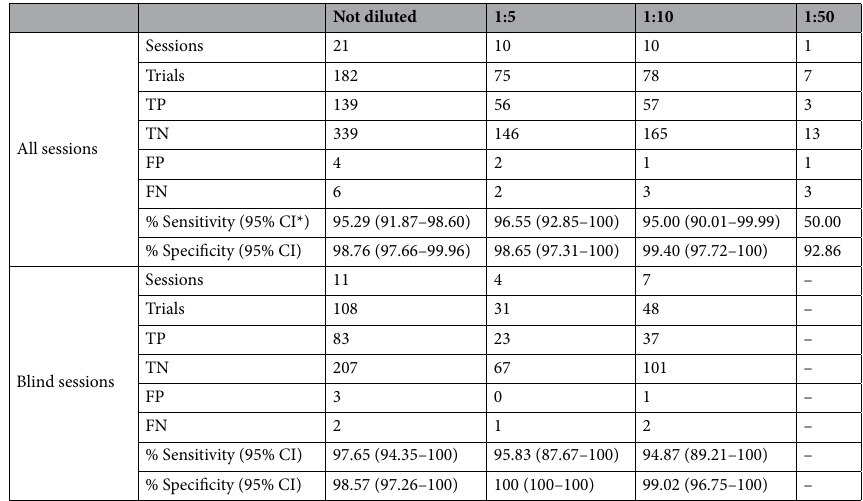
Table 3. Detection of OST3 diluted samples by Dog#1. *Confidence interval calculated with the values obtained in the different sessions.